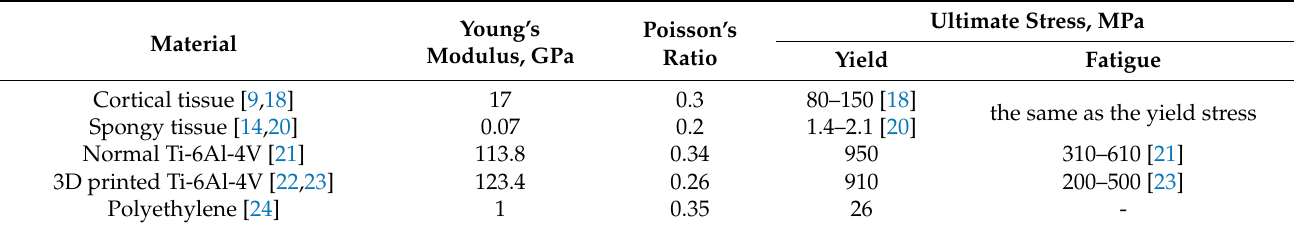
Table 2. Material properties used in the present